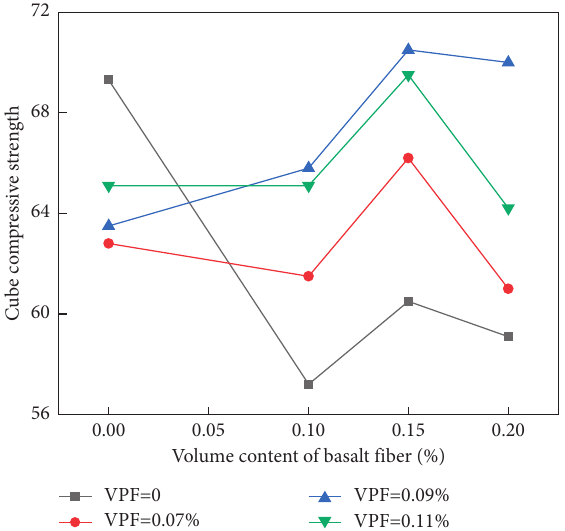
Figure 3: Axial compressive strength effect of concrete with dif- ferent fiber volume